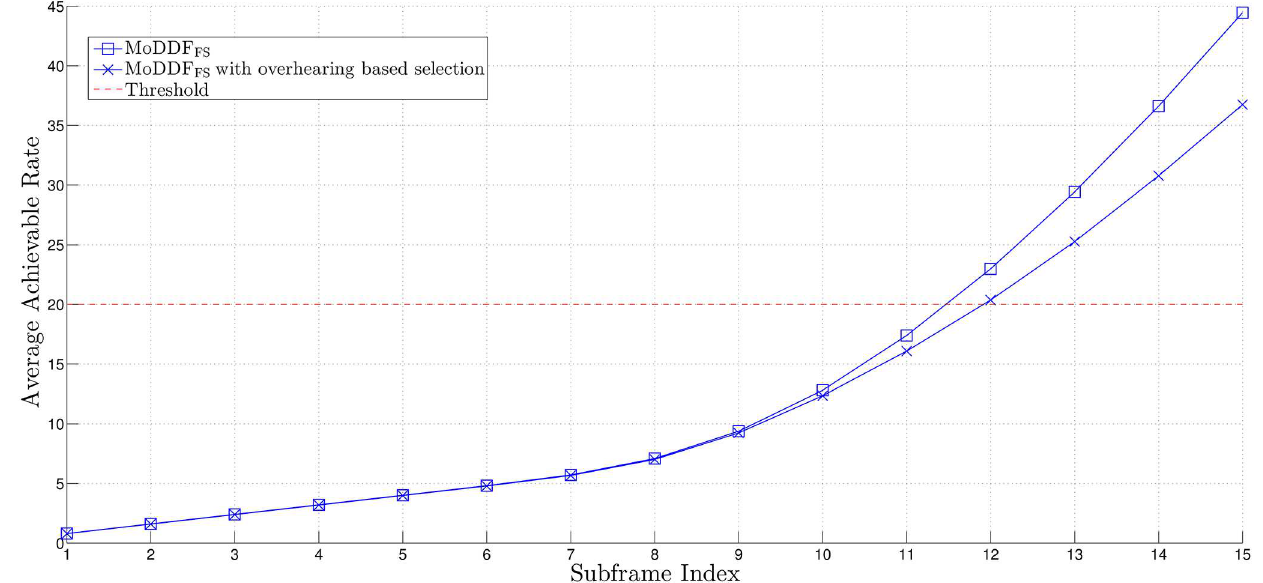
¼ 2 dB, R th = 20, and γ T = 20 dB. SD